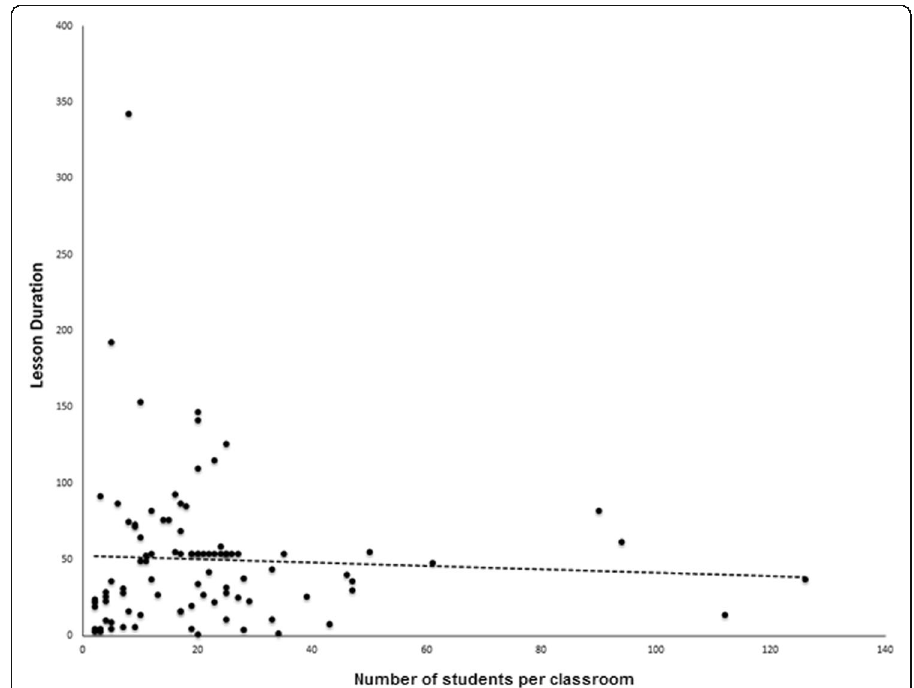
Fig. 2 Average duration of the monitored lessons (in minutes) is plotted against the class size (number of students), indicating that lesson duration is independent of class size